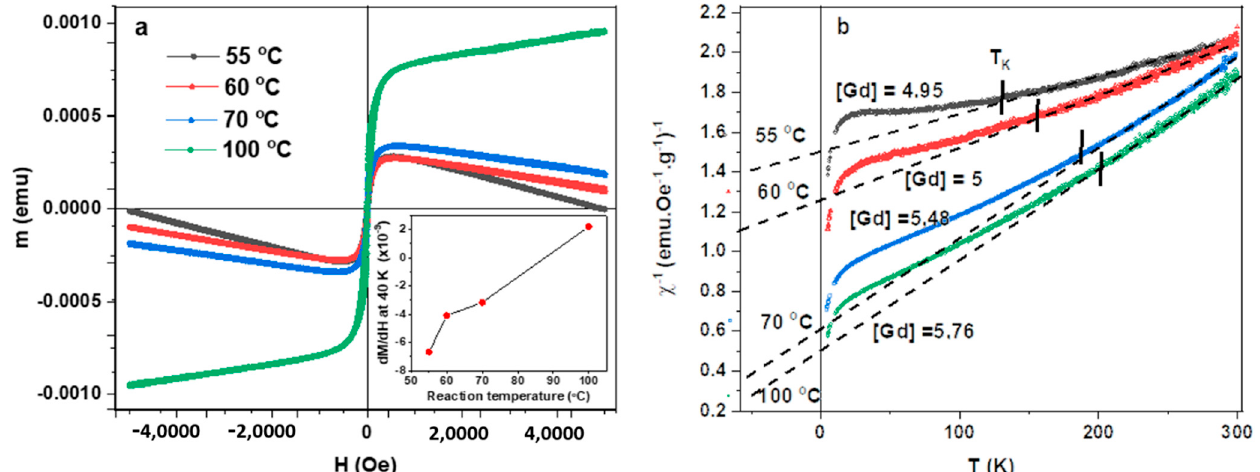
Figure 6. ( a ) The intrinsic diamagnetic response of the nanotubes is reduced with increasing temperature; indicating disruption of the conduction π -electron network as more Gd-DTPA is attached to the nanotubes, evident through the increase in slope of high field data. Inset—The slope increases with increasing reaction temperature at higher fields. ( b ) Temperature dependence of the magnetic susceptibility indicates an interactive magnetic system with dominant antiferromagnetic interaction. The Weiss temperature is extracted by fitting the Curie–Weiss law and shows a pronounced increase in value with increasing reaction temperature. The breakdown of the linear behavior at low temperatures signifies the modification in spin-interactions due to the functionalization process and can be linked to the onset of a Kondo effect with Kondo temperature denoted by T K .